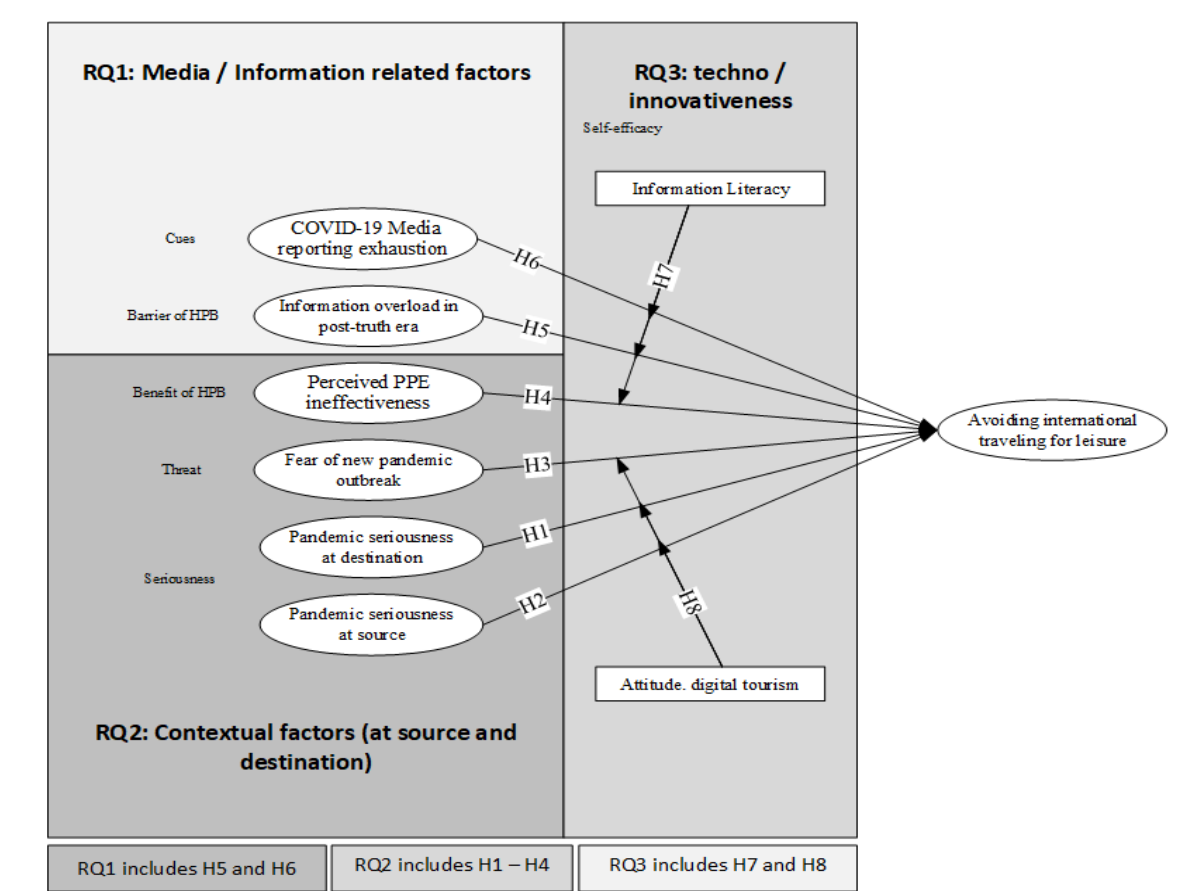
Figure 1. Graphical view integrating research questions and proposed hypotheses.